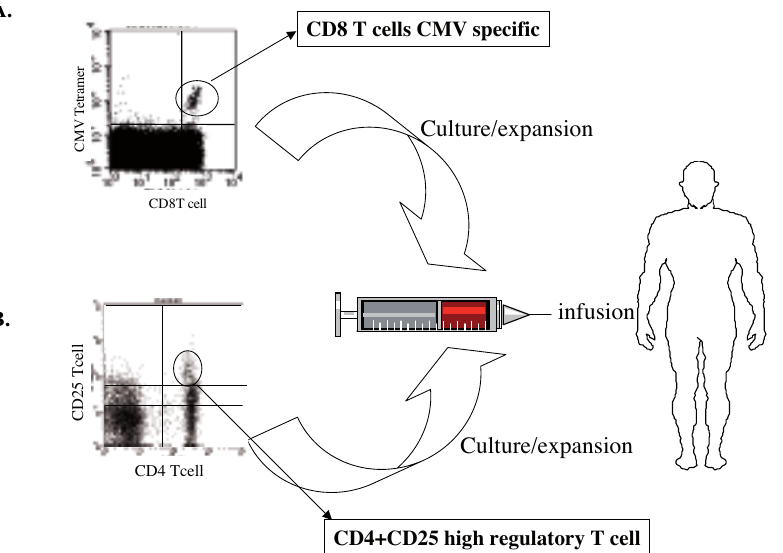
Figure 3 Cellular therapy and organ transplantation . ( A). CD8 specific T cells can be detected in CMV positive patients by a tetramer. CD8 specific T cells can be selected, cultured ex vivo, amplified and reinfused into immunosup- pressed patients who have escaped antiviral therapy. ( B) : CD4 + CD25 high T cells have regu- latory properties. CD4 + CD25 high T cells can be selected, cultured ex vivo, amplified and reinfused into the patient to induce tolerance or to treat